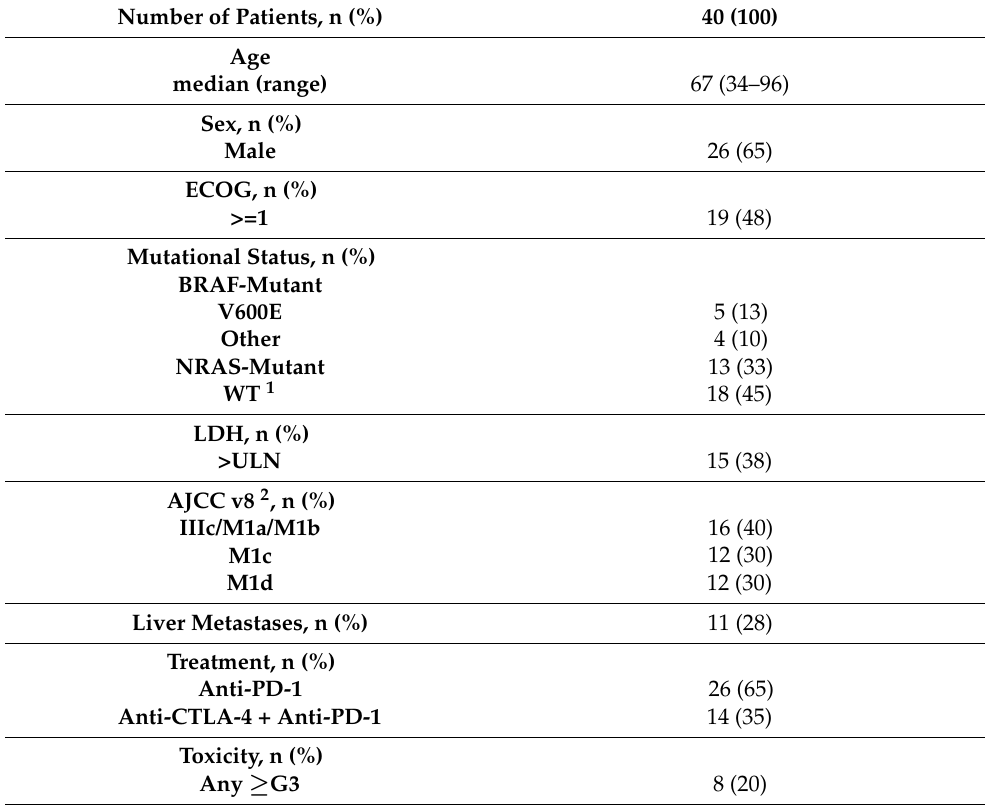
Table 1. Baseline patient demographics and clinical